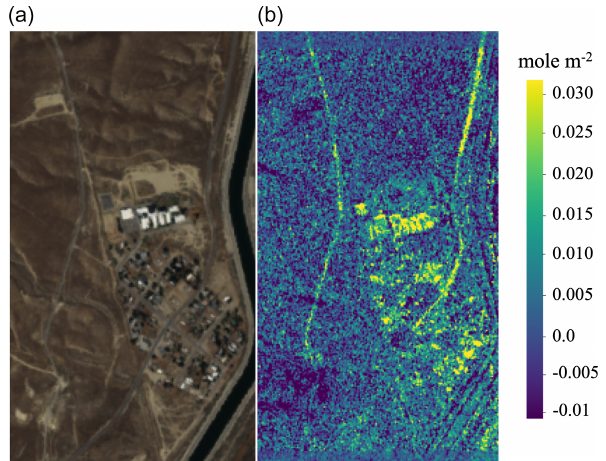
Figure 1. Example of the systematic outliers from a retrieved AVIRIS-NG scene (b) compared with an RGB image (a)